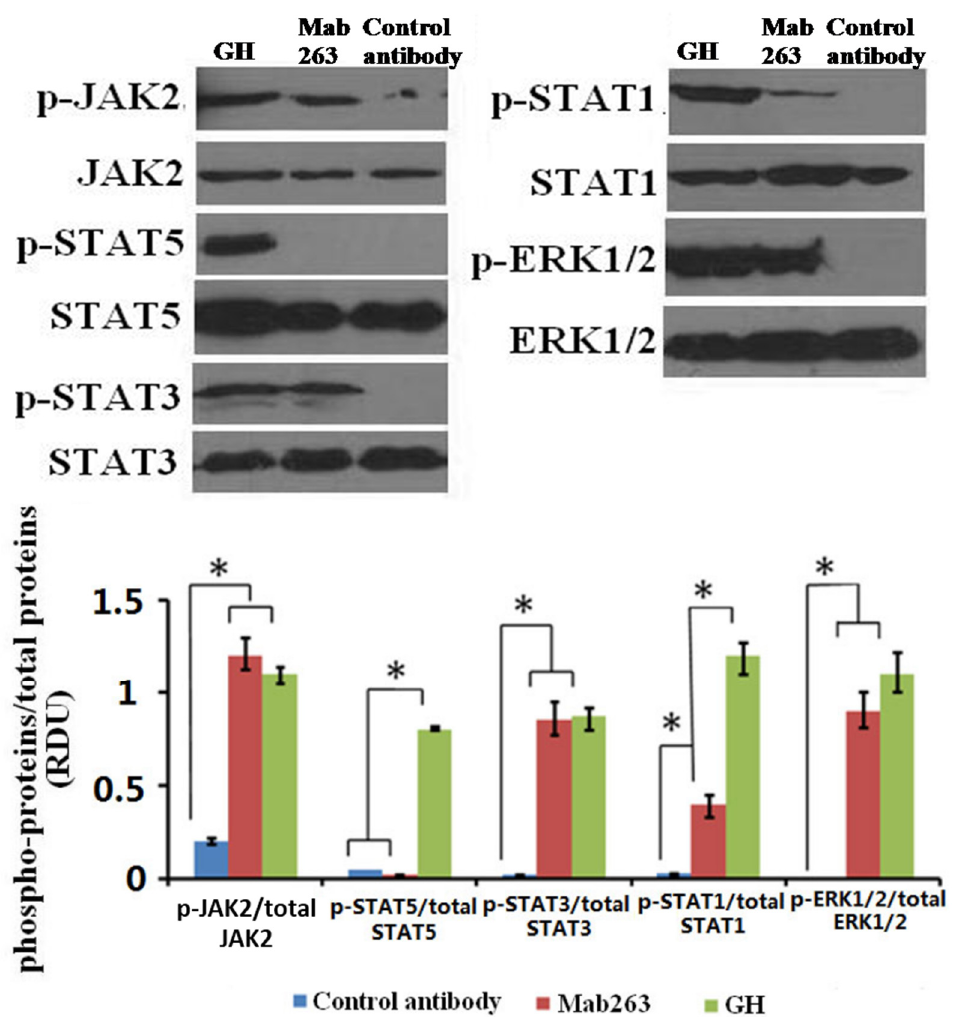
Figure 2. The intracellular signaling pathway(s) induced by Mab263 in the rat GHR cell model. CHO (Chinese hamster ovary)-GHR638 cells were pre-treated as described in the Materials and Methods. The CHO-GHR638 cells were challenged with GH (20 nM), Mab263 (20 nM) or control antibody (20 nM) for 30 min. The cells were solubilized in lysis buffer on ice for 30 min, and the cell extracts were then harvested and concentrated by ultrafiltration. The sample was separated on an SDS-PAGE gel and transferred to PVDF membranes. After blocking and washing, the membranes were probed with antibodies recognizing phosphorylation of janus kinase 2 (p-JAK2), phosphorylation of signal transducer and activator of transcription 1/3/5 (p-STAT1/3/5) and phosphorylation of extracellular signal-regulated kinase 1/2 (p-ERK1/2). After washing, secondary antibody was added to detect bound antibody using the ECL detection system. After detection, the membranes were stripped and re-probed with antibodies against the total JAK2, STAT1/3/5 and ERK1/2 proteins to verify equal protein loading in each lane; and ( Bottom ) The corresponding histograms of data from three separate western blot analyses. Densitometry data for p-JAK2, p-STAT1/3/5 and p-ERK1/2 were normalized to that of total JAK2, total STAT1/3/5 and total ERK1/2, presented as relative densitometry units (RDU) and expressed as the means ± SE. * p < 0.05 compared with the control values; p,